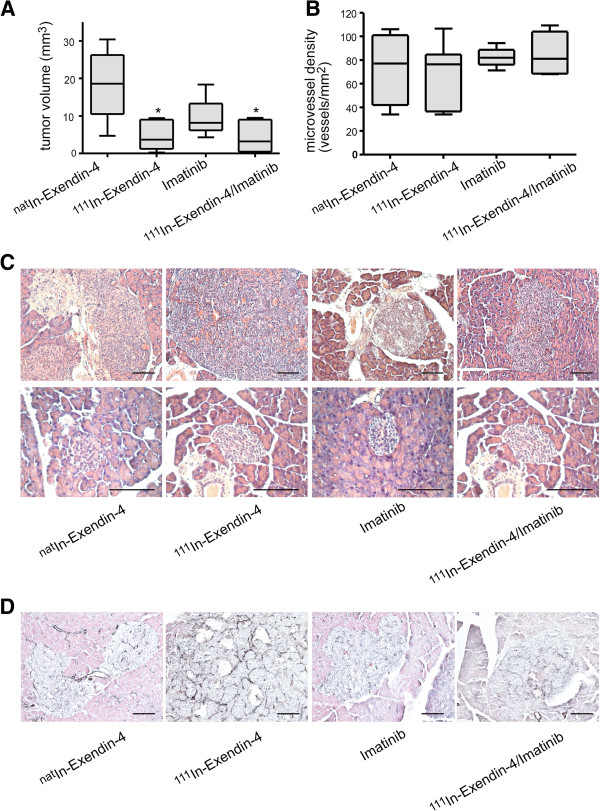
Therapeutic efficiency of combination therapy with [Lys40(Ahx-DTPA-111In)NH2]-exendin-4 and imatinib. (A) The combination of [Lys40(Ahx-DTPA-111In)NH2]-exendin-4 with imatinib has no additive effect on tumor burden (*p < 0.05, Kruskal-Wallis test). (B) The microvessel density is not affected by the (combination) therapy with imatinib. (C) H&E staining of tumor sections after the completion of therapy. Tumor necrosis can be seen under treatment with [Lys40(Ahx-DTPA-111In)NH2]-exendin-4. However, the combination treatment with imatinib does not alter the tumor morphology. (D) The microvessel density is unaffected by treatment with [Lys40(Ahx-DTPA-111In)NH2]-exendin-4 and/or imatinib. Size bars, 100 μm.